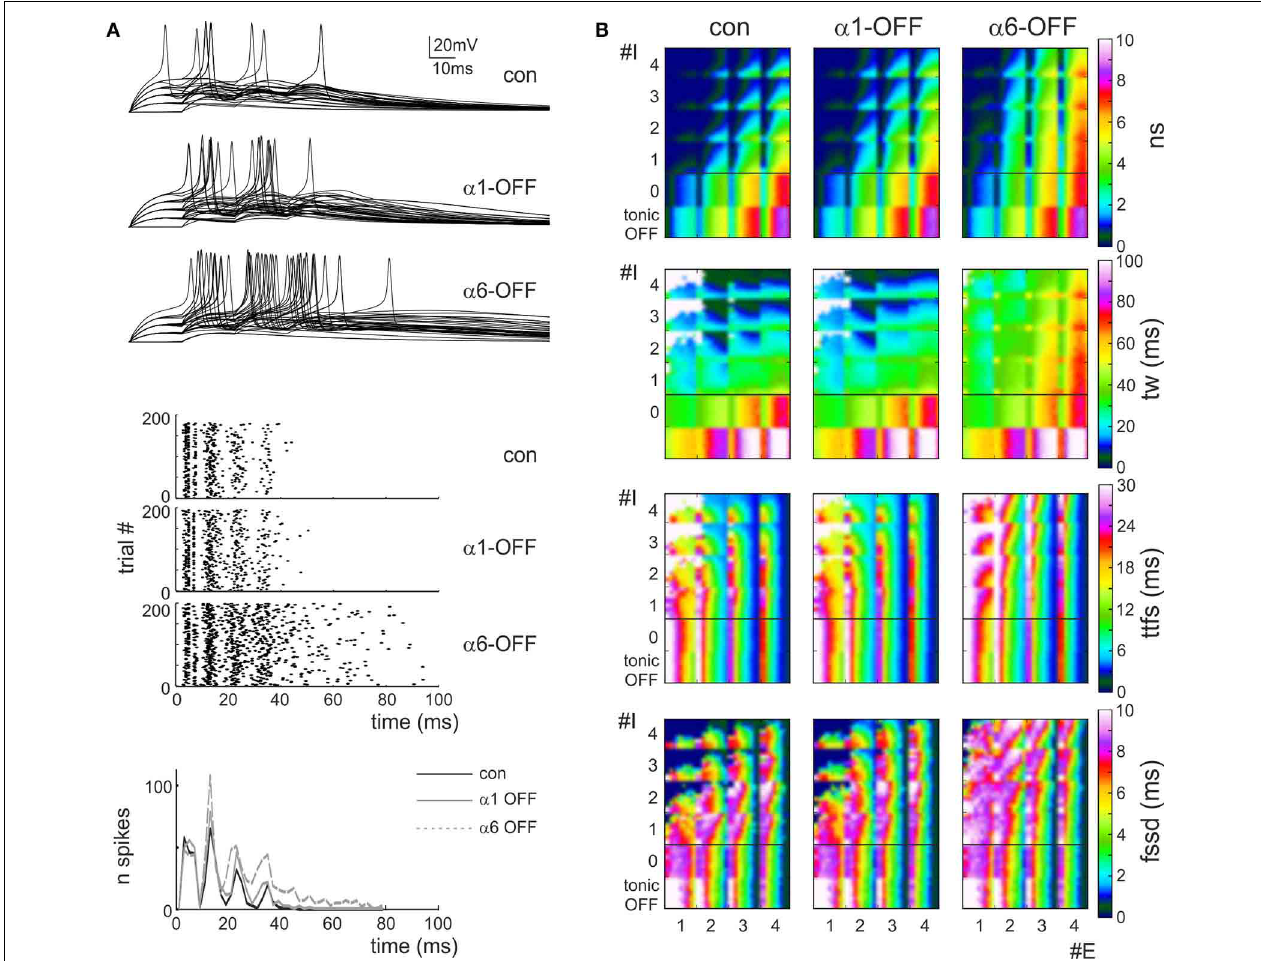
containing receptors ( α 1-OFF and α 6-OFF) and of the GABA tonic current (tonic OFF). The E/I space is generated by reporting the number of active excitatory (1 < E < 4) and inhibitory (0 < I < 4) synapses on the two axes and by using colors to represent the parameter values. For each E/I combination, a subquadrant identifies a pE/pI subspace (0 < pE < 1 on the x-axis, 0 < pI < 1 on the y-axis). Note that α 6 subunit-containing receptors are most effective in modifying the